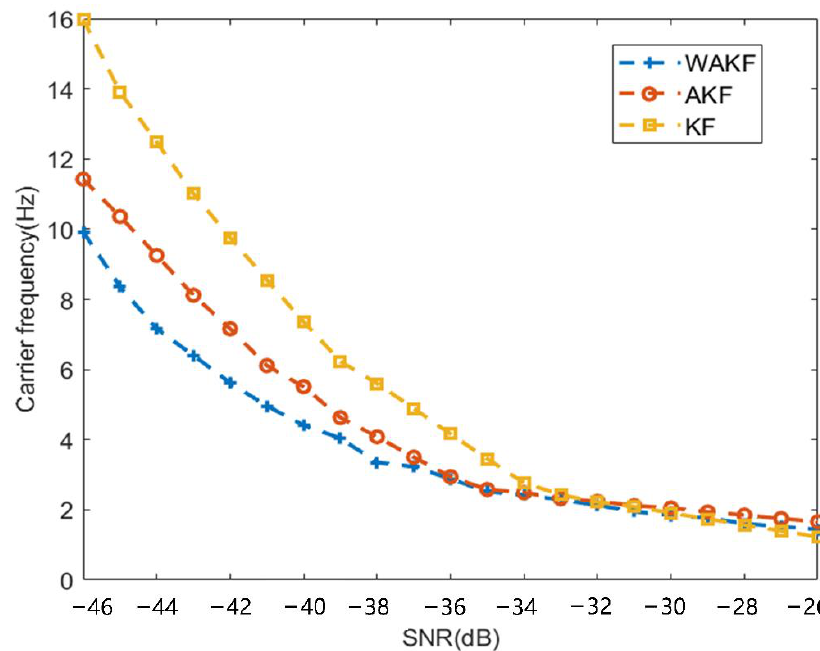
Figure 6. Frequency estimation errors of three algorithms under different SNRs.